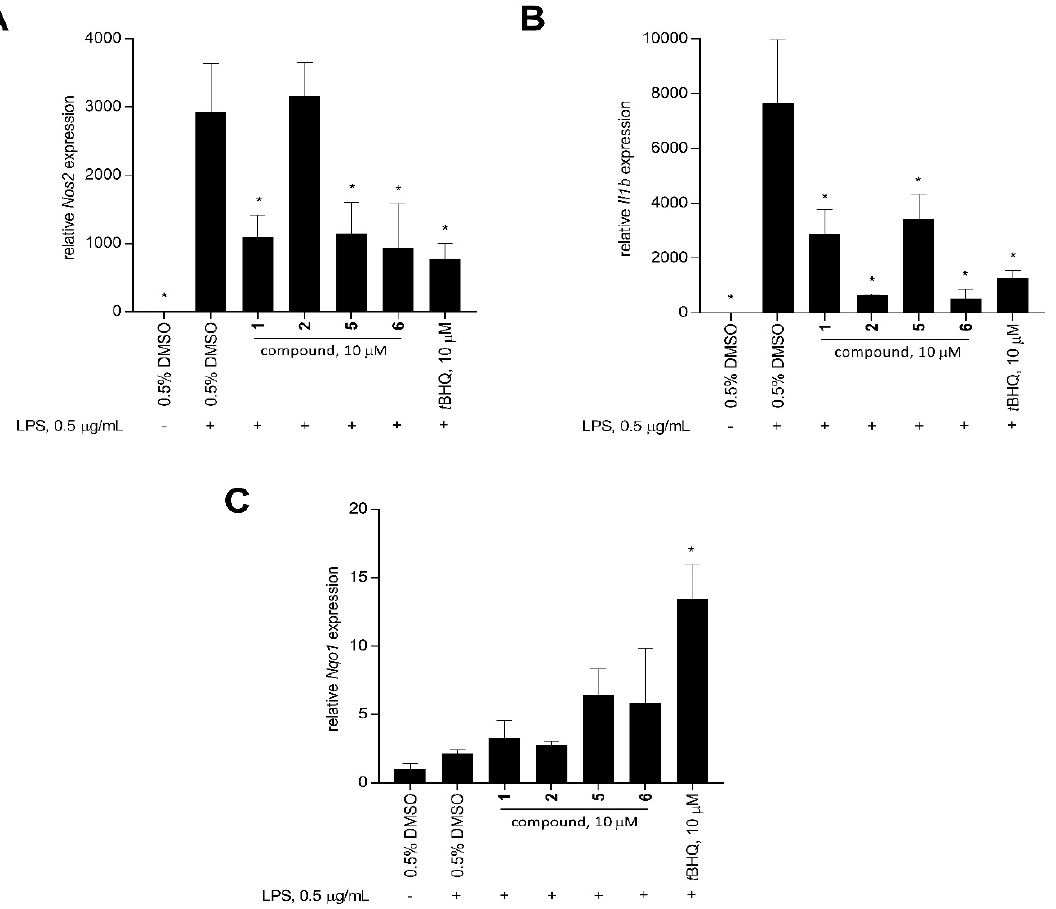
Figure 6. Relative expression (mean + SD, n = 3) of pro-inflammatory and cytoprotective genes: ( A ) Nos2 , ( B ) Il1b , and ( C ) Nqo1 in LPS-stimulated RAW 264.7 murine macrophage cells after 12-h treat- ment with 10 μ M of xestoquinone ( 1 ), adociaquinone B ( 2 ), 15-hydroxymethylxestoquinone ( 5 ), 2:1